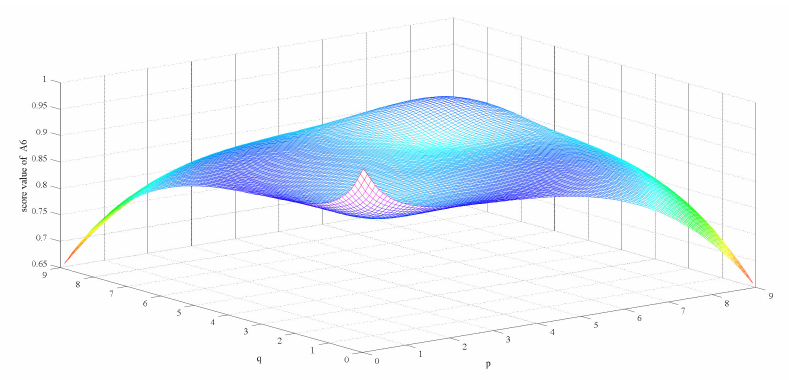
Figure 6. Score value of ordinary non-medical mask ( A 5 ) when p , q ∈ [ 0.1,9 ] .